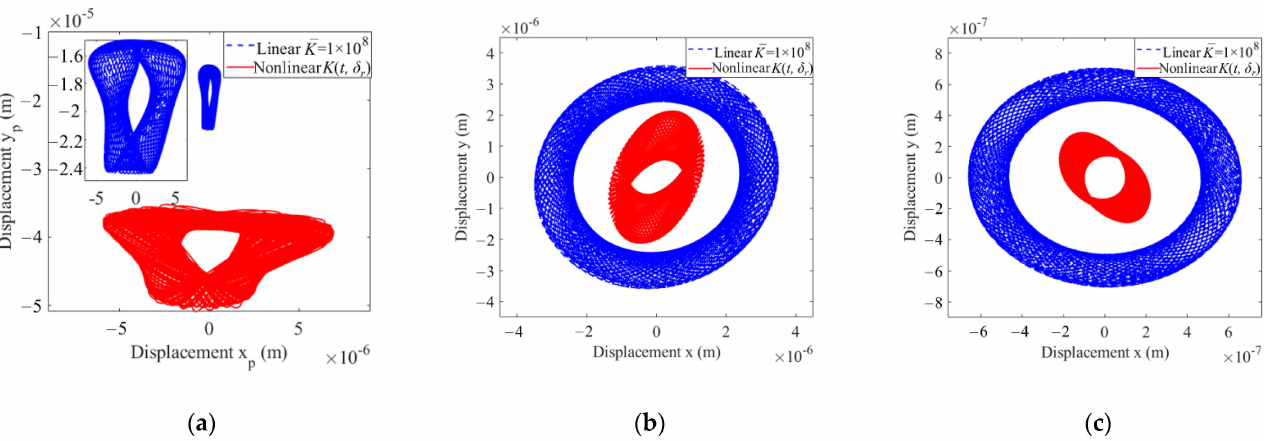
Figure 17. Central trajectory of rotating components of PGS: ( a ) planet gear; ( b ) sun gear; ( c ) planet carrier.